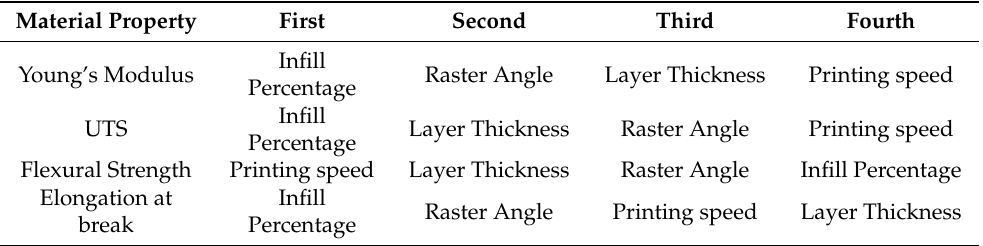
Table 7. Table ranking parameters according to influence on PEEK mechanical properties as deter- mined by ANOVA.